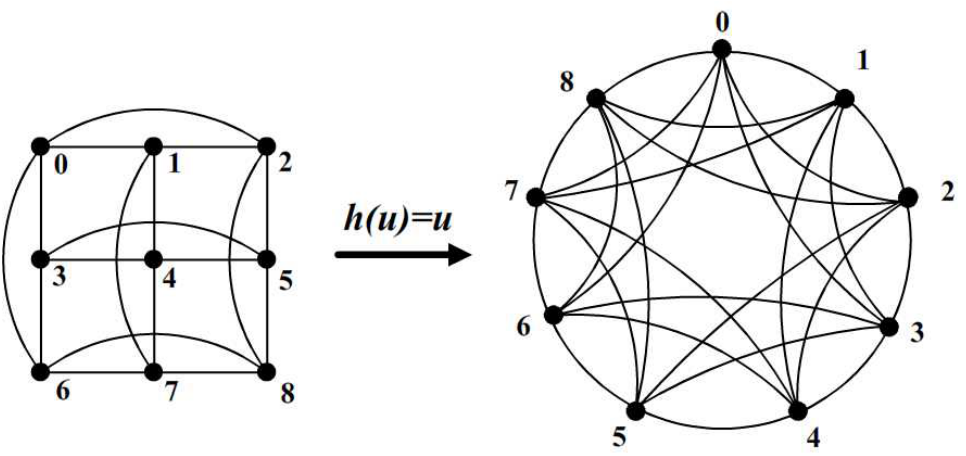
Figure 3. Embedding H 2 into G ( 9; ±{ 1,2,3 } )